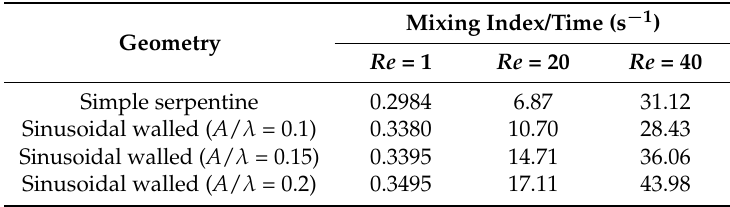
Table 1. Comparison of mixing index to residence time